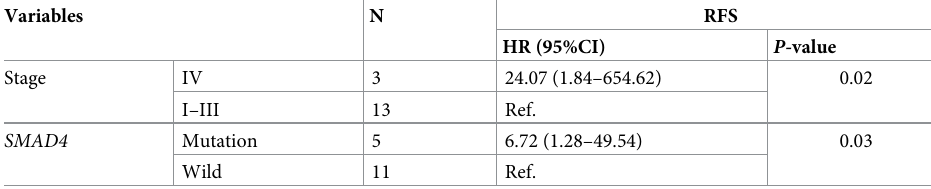
Table 7. Multivariate association with recurrence-free